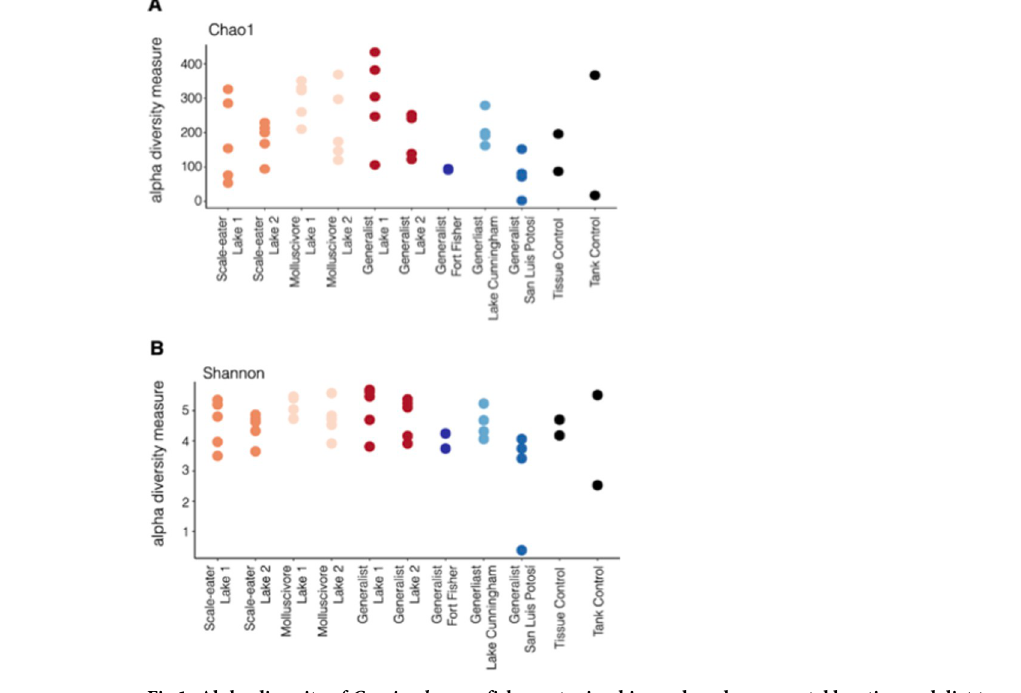
Fig 1. Alpha diversity of Cyprinodon pupfishes gut microbiomes based on parental location and diet type along with controls. Lake 1 indicates Crescent Pond and Lake 2 represents Osprey Lake, both located on San Salvador Island in the Bahamas. Alpha diversity is represented by (A) Chao1 and (B) Shannon diversity for the estimate of species richness from gut microbiomes from all fishes in this study.